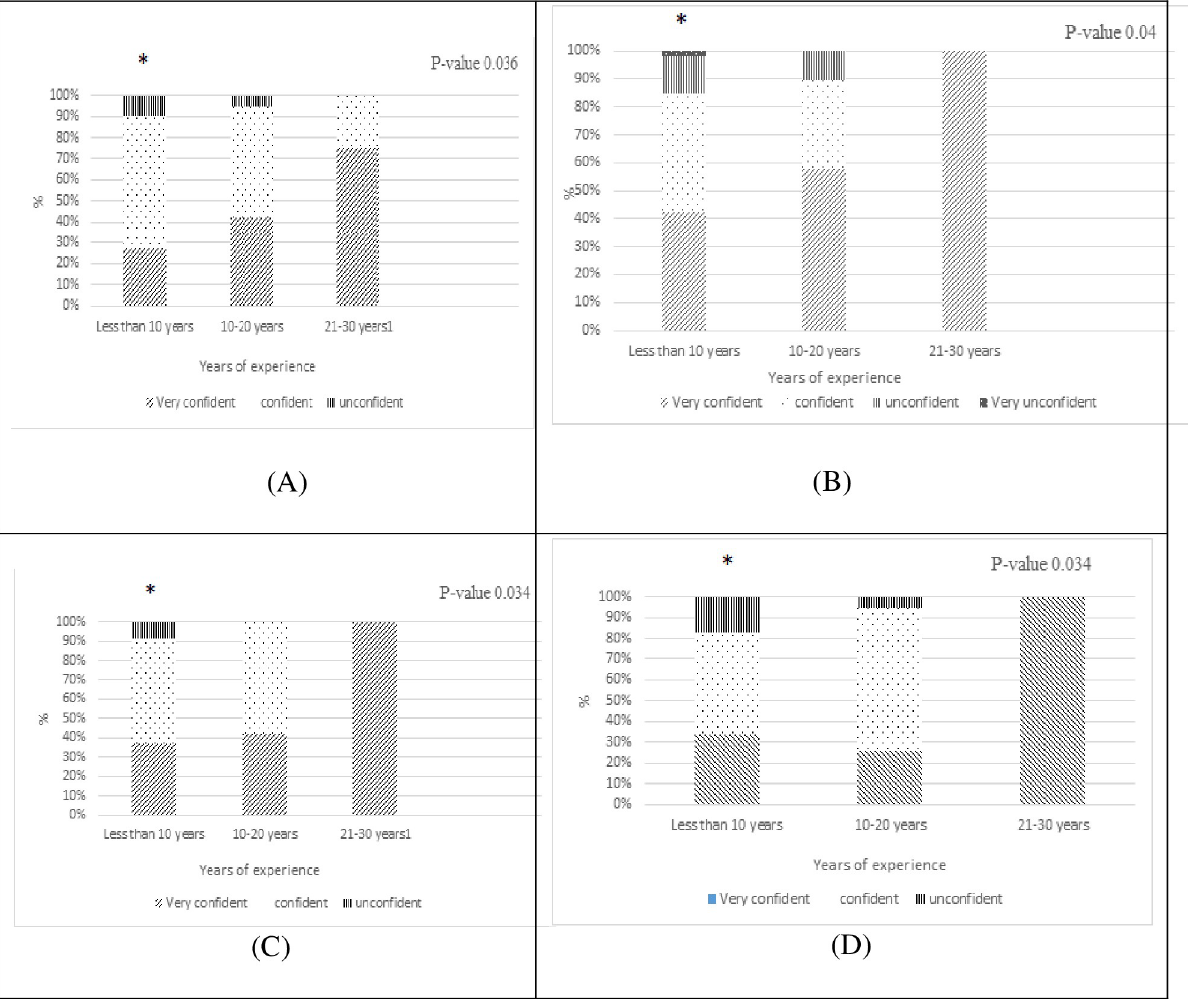
Fig 5. Significant relationship between physician’s years of experience and level of confidence of prescribing antibiotics in various scenarios, ( � significant p -value < 0.05 compared to more experienced physicians). (A) choosing the correct antibiotic scenario. (B) choosing the correct dose and interval of administration scenario.(C) interpreting results. (D) Planning the duration of the antibiotic